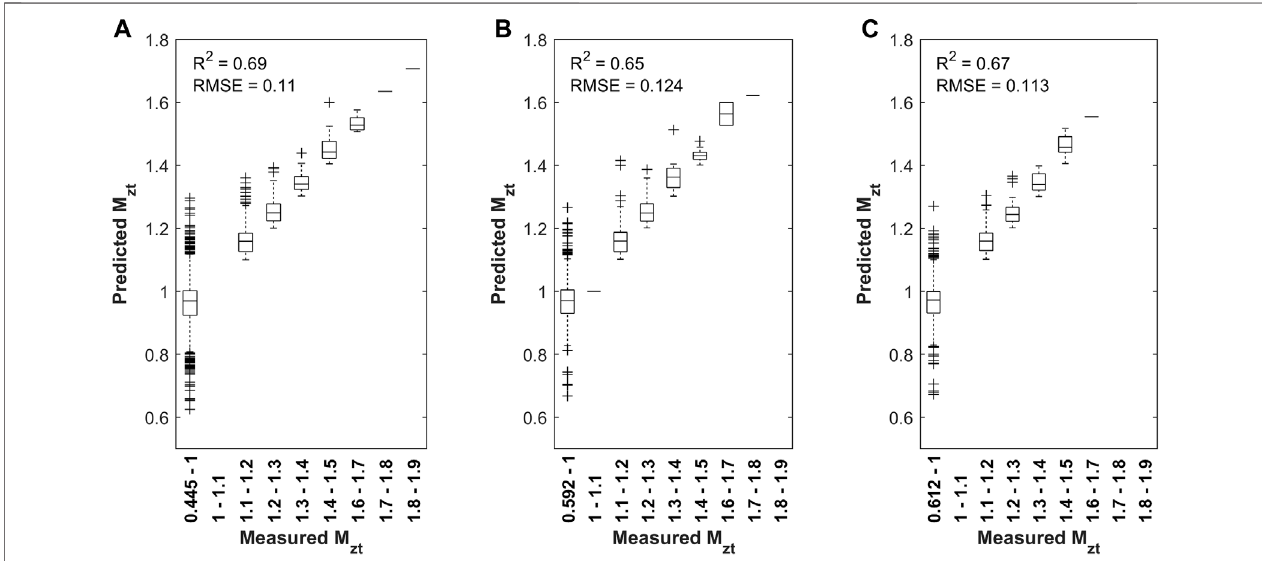
FIGURE 14 | Training, testing, and validation of a single layer, 30 neuron model for all terrain cases using 100 m horizonal spacing DEM data. (A) Training (B) Testing (C) Validation.